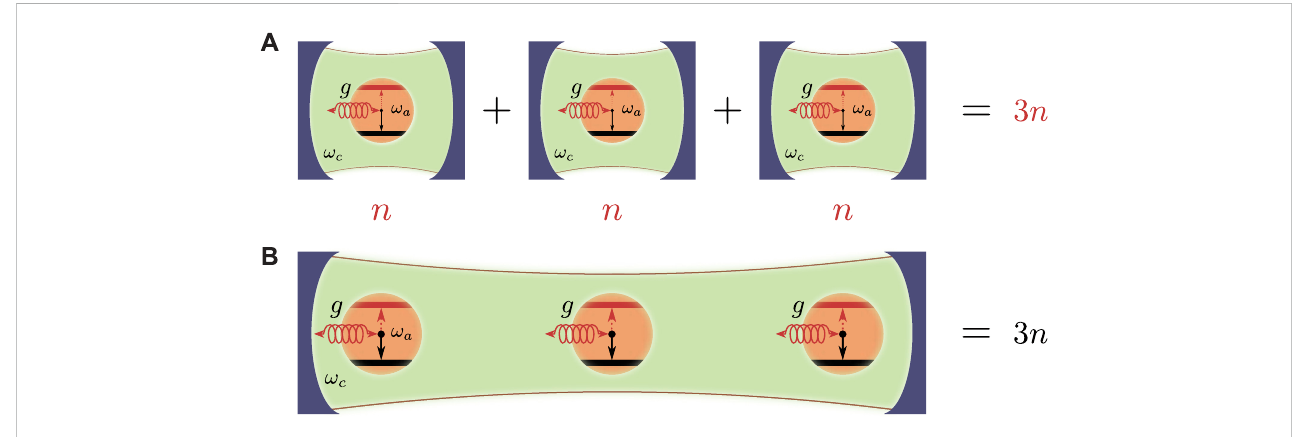
FIGURE 2 (A) Individually charging three spins in a parallel protocol. Each cavity is fi lled with n photons and in total 3 n number of photons are used. (B) The three spins are collectively charged inside a single cavity. To make a fair comparison the same amount of photons should be provided as in the parallel